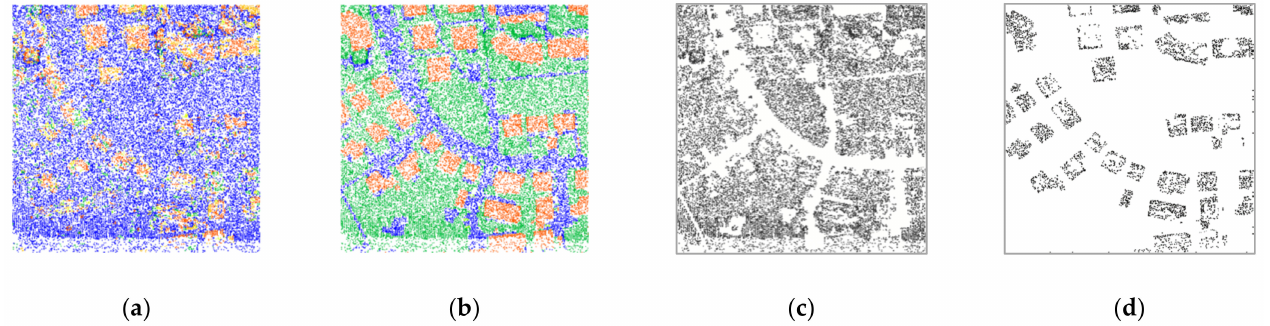
Figure 26. Results of semantic segmentation of new data 2 for Case 2: ( a ) prediction; ( b ) ground truth (i.e., label data); ( c ) difference between prediction and ground truth for all classes; ( d ) difference between prediction and ground truth for building class only.